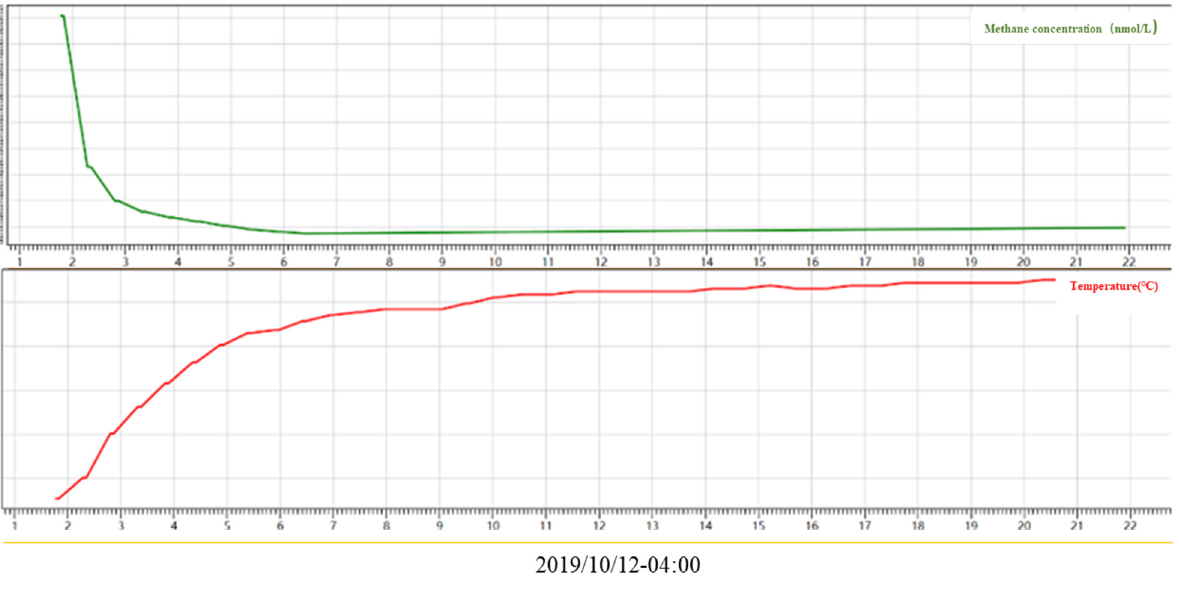
Figure 10. Test data at a water depth of 1250 m (18,263–18,259 sound communication module paired successfully).